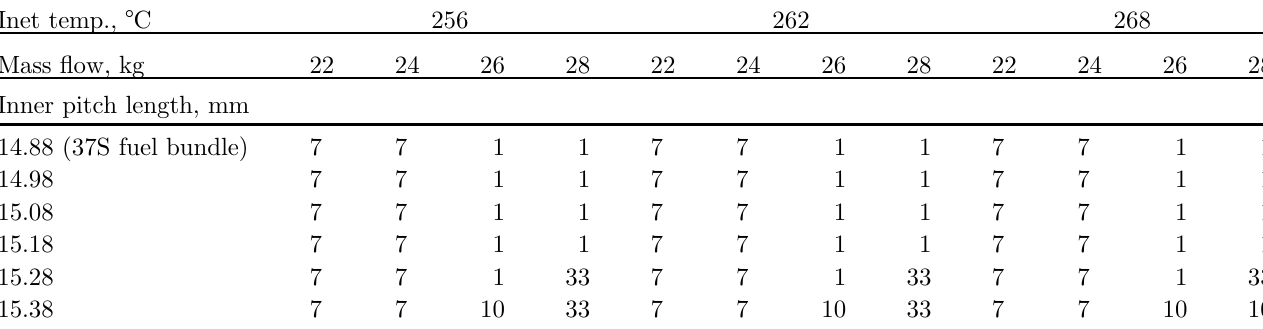
Table 3. Subchannel location of the 1st CHF occurrence for 5.1% crept pressure tube. Inet temp., ° C